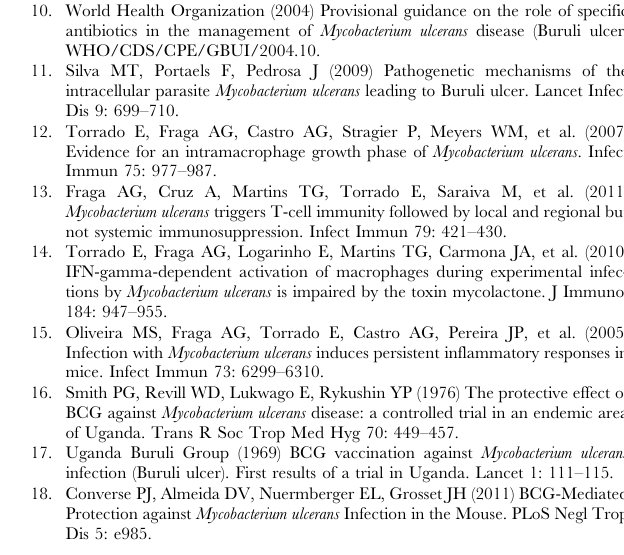
Figure S1 BCG vaccination induces an early Th1 N cytokine profile in M. ulcerans -infected footpads. Mice were either non-immunized ( ) or immunized with BCG ( # ) two months before challenge. All mice were infected in the footpad with 4 log 10 CFU of M. ulcerans 98–912. At different times post- infection, total RNA from the footpad was extracted and the presence of mRNA for IL-4 (A), IL-10 (B), and IL-17 (C) was assessed by real-time PCR. Data points represent the mean 6 SEM ( n = 5–8) for each time point. Statistical significance was